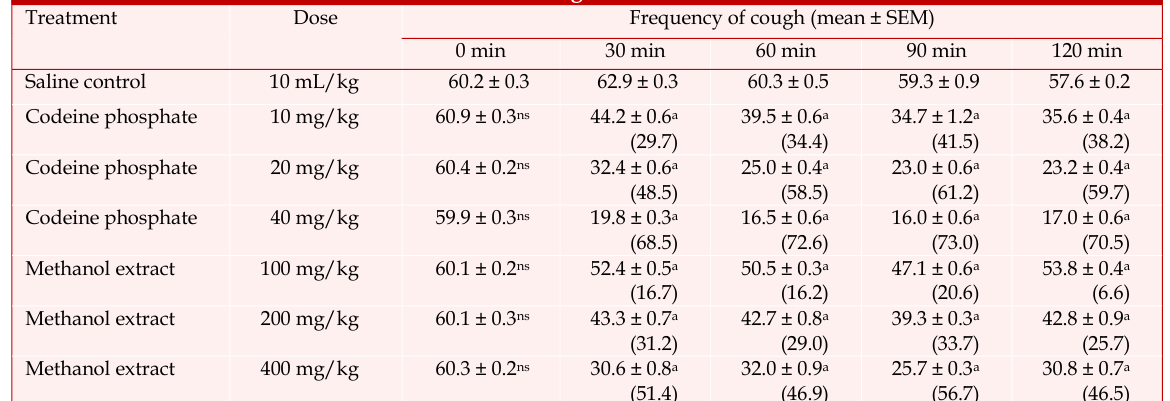
Effects of Coccinia grandis methanol extract and codeine phosphate on the cough induced by sulfur dioxide gas in